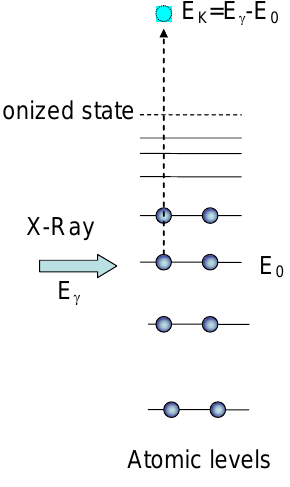
FIGURE 13. Scheme of XPS